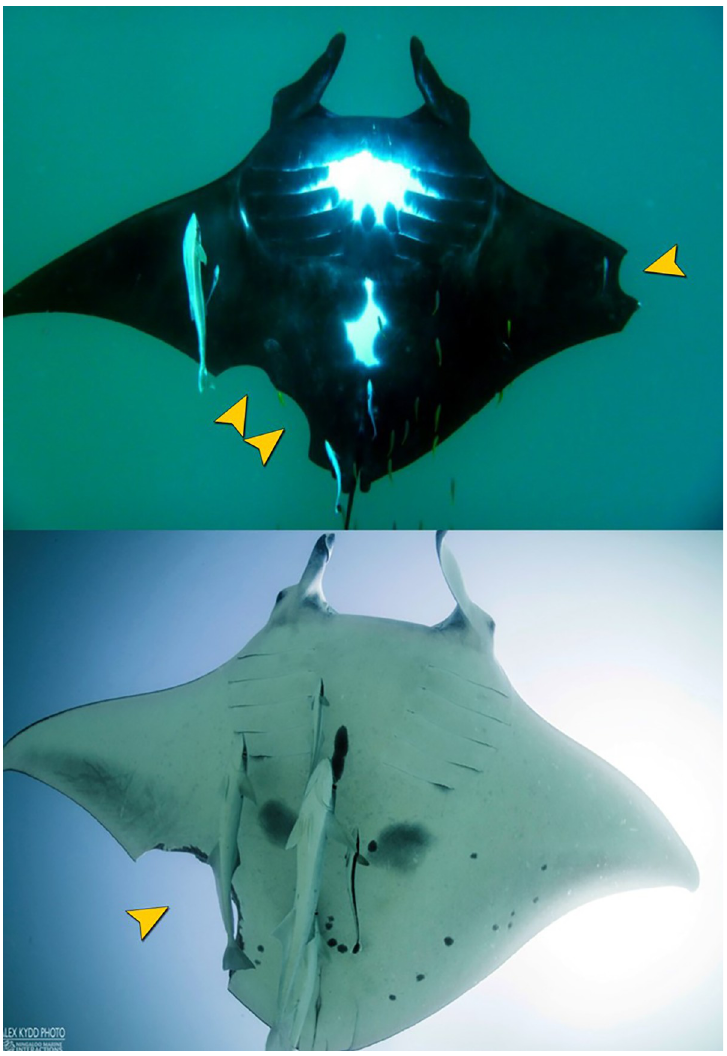
Fig 4. Examples of clear predation events on reef manta rays Mobula alfredi . Yellow arrows indicate the bite site on the fins.